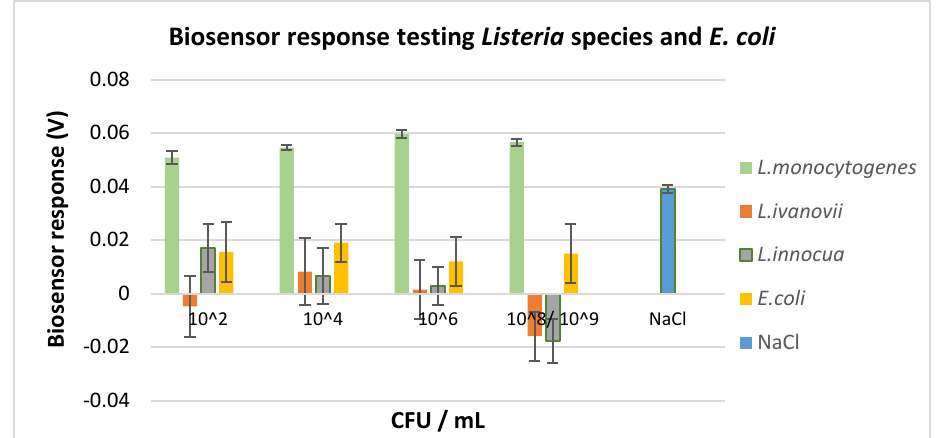
Figure 7. Response of p60-biosensor with 5 μg mL −1 antibody concentration at broth samples of L. monocytogenes, L. ivanovii , L. innocua , and Escherichia coli at four different population levels ( L. monocytogenes, L. ivanovii , L. innocua: 2, 4, 6, and 9 log CFU mL −1 ; E. coli : 2, 4, 6, 8 log CFU mL −1 ).